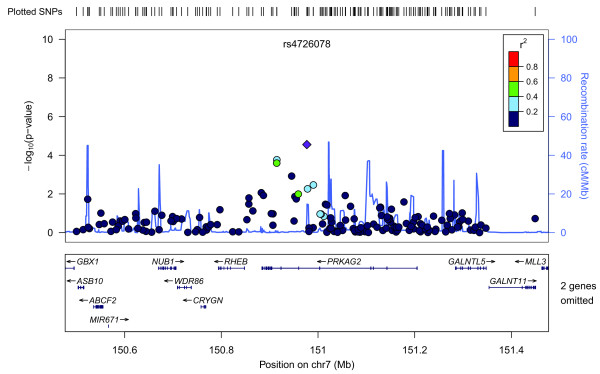
Plot of regional association signals for rs4726078 forwarded for validation.